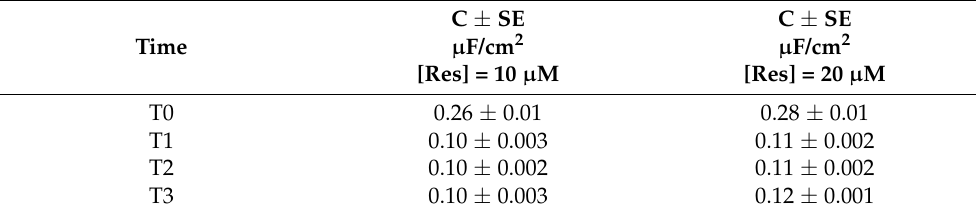
Table 5. Capacitance variation in DOPS:DOPE PLM. Mean values of the membrane capacitance (C ± SE) calculated at T0, T1, T2, and T3, for which meanings are reported in the legend to Table 3. The mean value was obtained from at least six